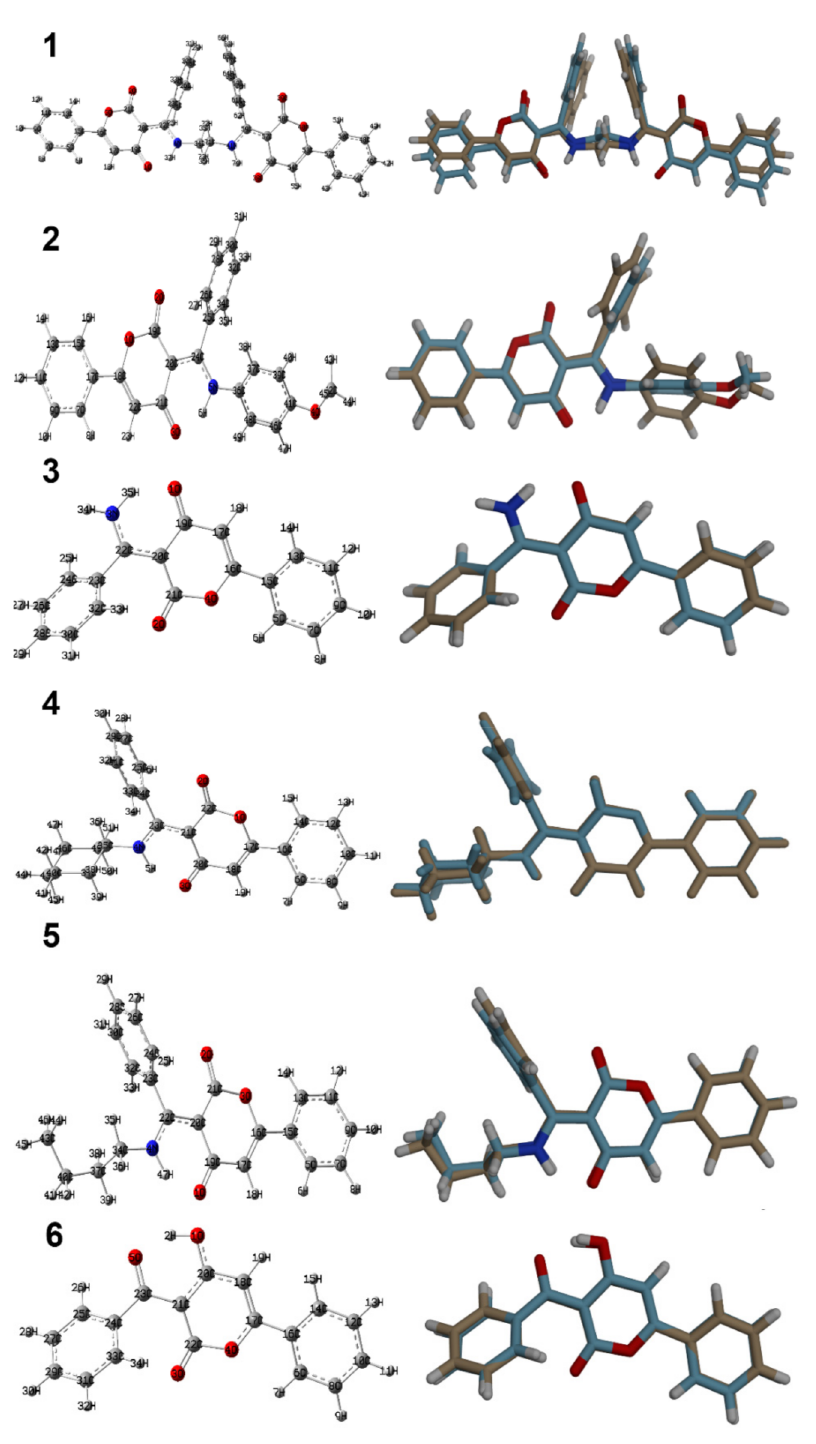
Figure 13. The optimized geometry ( left ) and overlay of the optimized with experimental structures, ( right ) for the studied